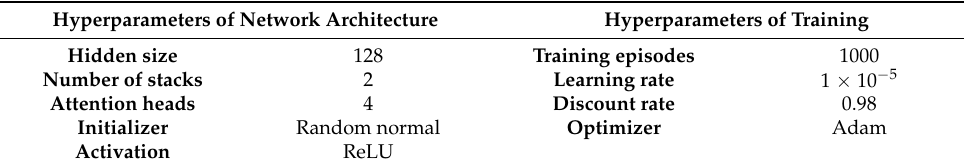
Table 4. Hyperparameters used in the experiments.